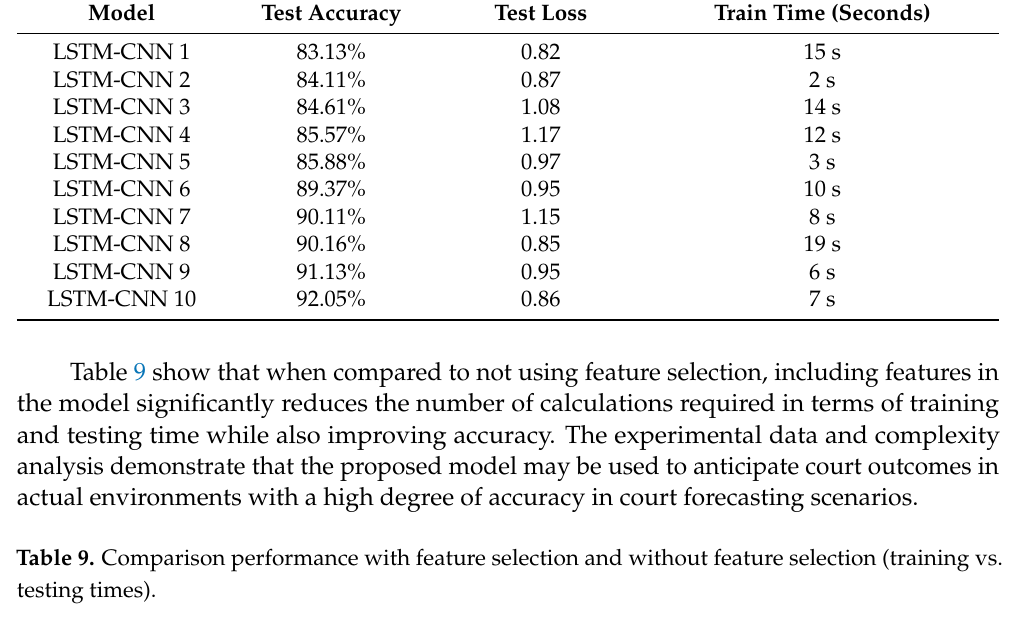
Table 8. The LSTM+CNN models’ test accuracy, test loss, and training time. Model